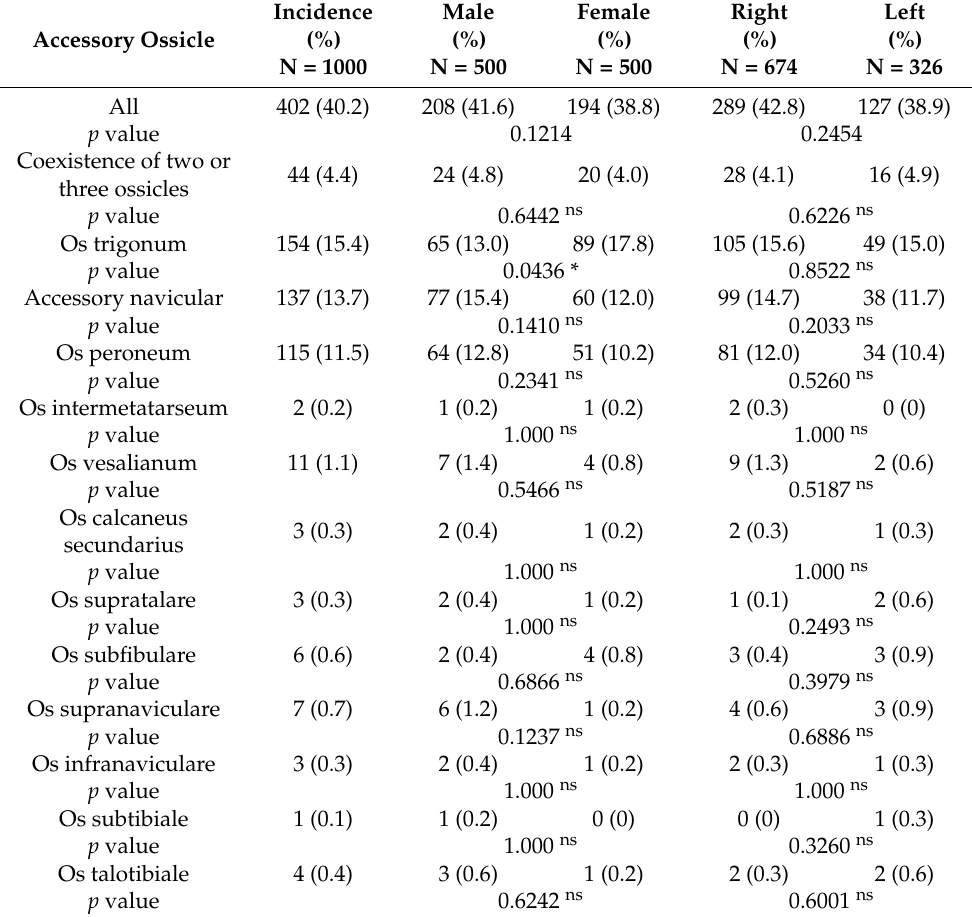
Table 1. Incidence of the accessory ossicles in the region of the foot and ankle.